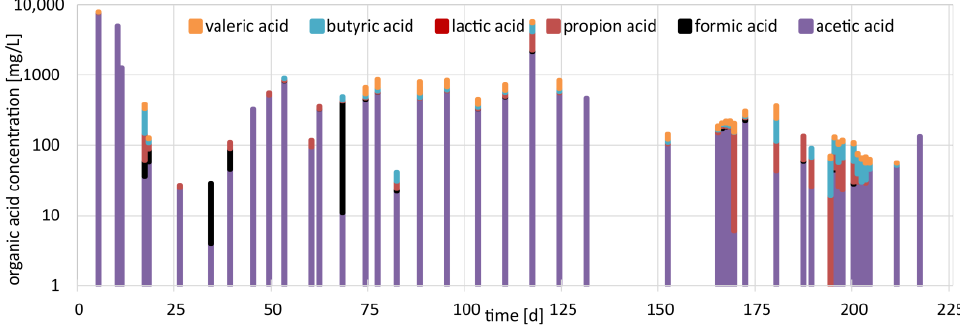
Figure 3. Organic acid concentrations in the trickling liquid, in logarithmic representation.